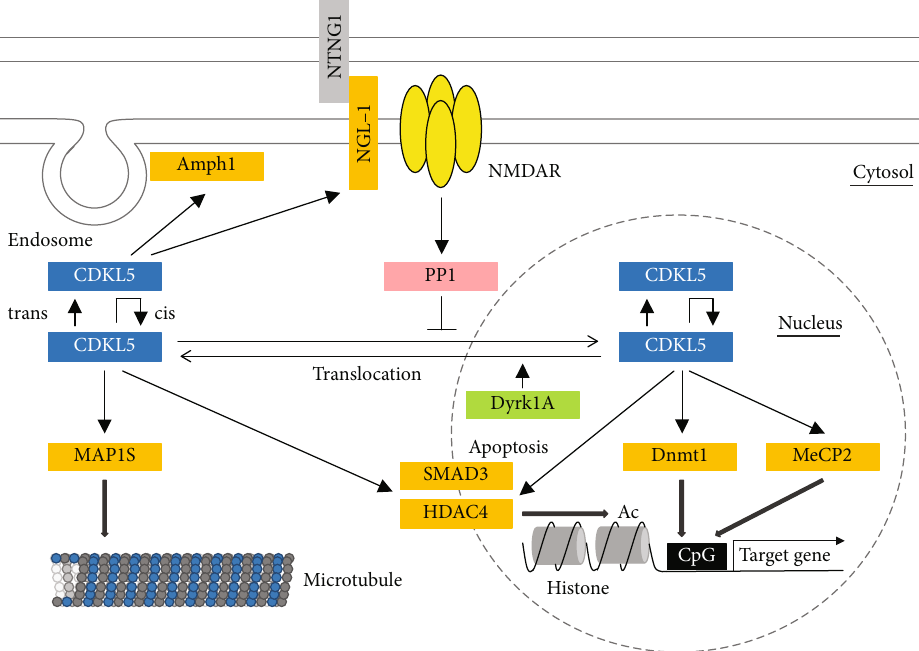
Figure 3: CDKL5 and phosphorylative signalling. Although CDKL5 is localised in both, the nucleus and the cytoplasm, its localisation is partly controlled by phosphorylation. Phosphorylation of CDKL5 by Dyrk1a results in its translocation to the cytoplasm. Dephosphorylation by PP1 stimulated by NMDA receptor-dependent signalling also induces strong accumulation of CDKL5 in the cytoplasm. Further, CDKL5 probably regulates its own activity via inter- and intramolecular autophosphorylation. MeCP2, Dnmt1, and HDAC4 are substrates of CDKL5, and their phosphorylation is predicted to transcriptionally regulate their control of gene expression. Finally, phosphorylation of Amph1 and NGL-1 may be involved in synapse formation and neurotransmission. Recently, phosphorylation of MAP1S has been shown to play an important role in its ability to bind to microtubules. cis: intramolecular autophosphorylation; trans: intermolecular